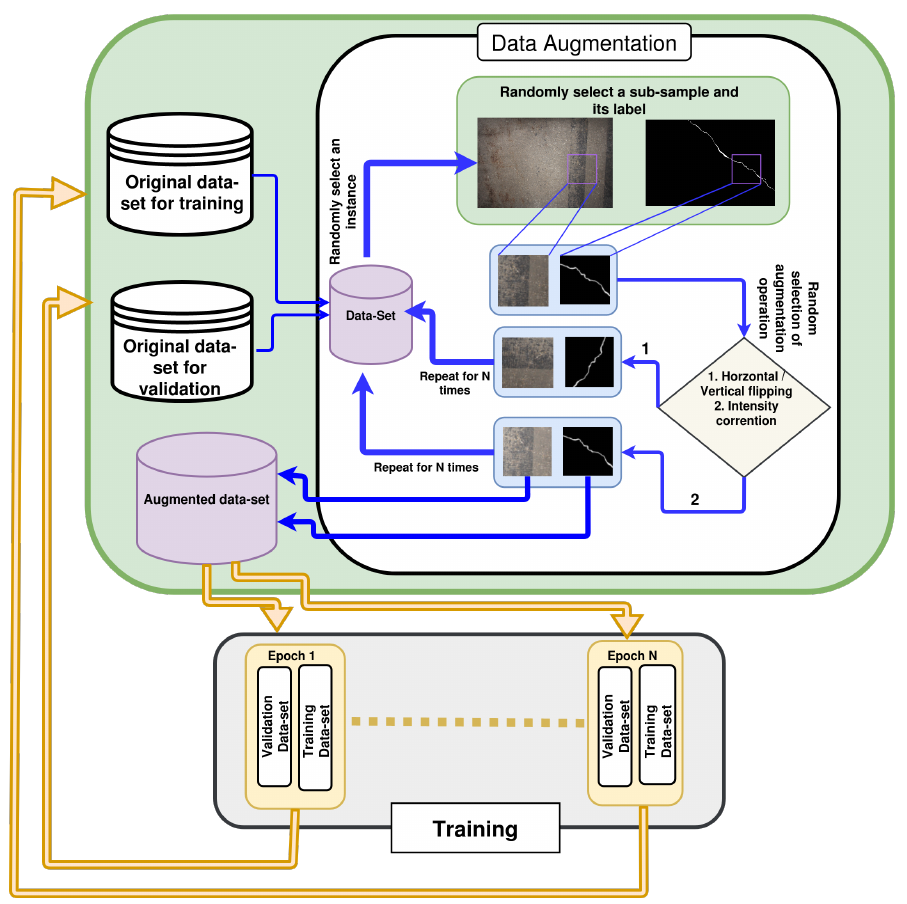
Figure 9. The training procedure with data augmentation